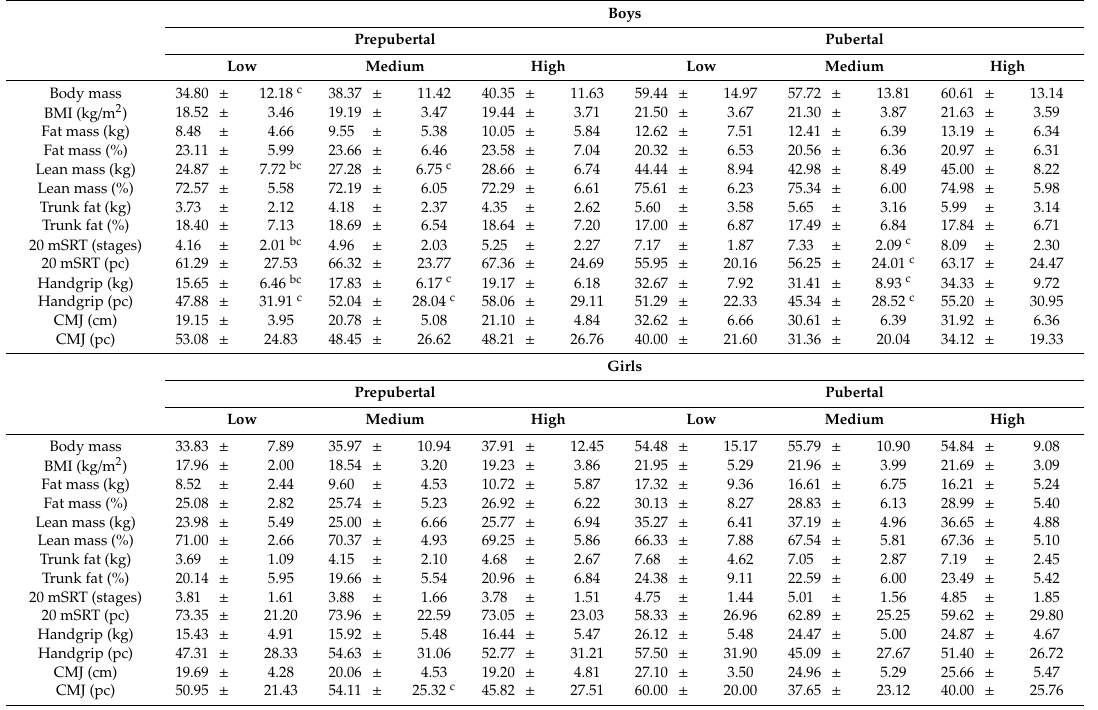
Table 2. Di ff erences in body composition and physical fitness parameters among di ff erent adherences to the Mediterranean diet.